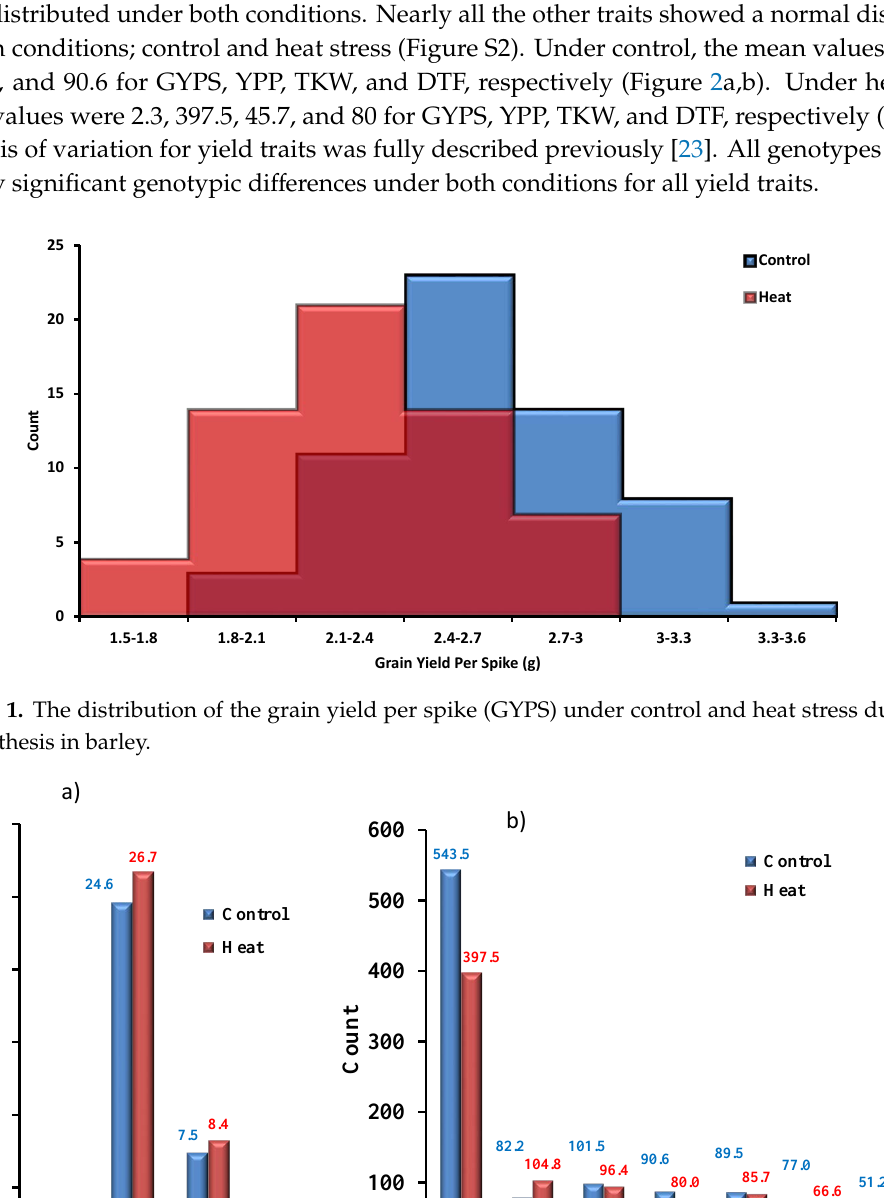
Figure 2. The histograms show the yield-related traits and the physiological traits in barley under control and heat stress during pre-anthesis in barley. Traits were grouped based on the range of their values; ( a ) traits with values less than 50 and ( b ) traits with values more than 50. The analysis of variation for yield traits (yield per plot (YPP), GYPS, and thousand kernel weight (TKW)) was fully described previously by Sallam et al. [24].